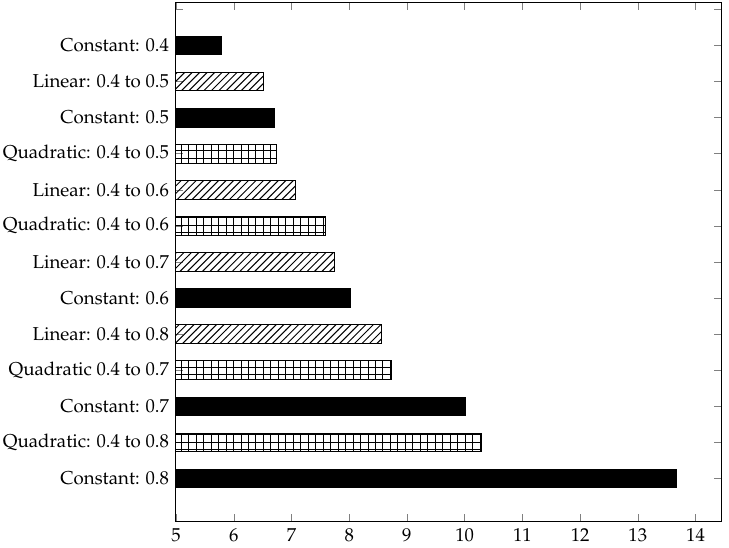
Figure 5. Surface [mm 2 ]/volume [mm 3 ] of gyroid structures in ascending